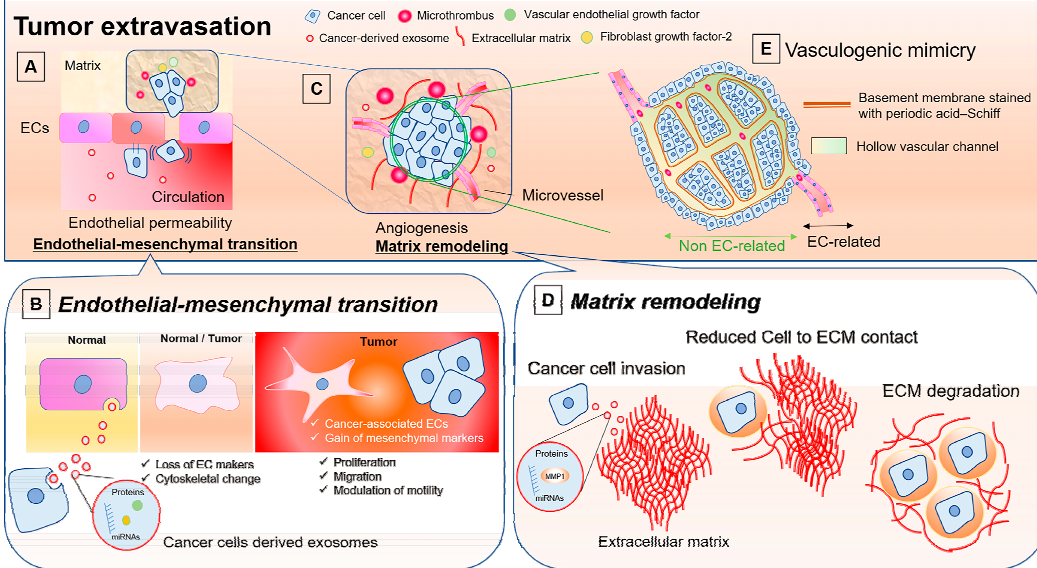
Figure 2. Effects of cancer-derived EVs on ECs in tumor extravasation. Attachment of circulating cancer cells to ECs and cancer-derived exosomes modulates tight junctions by activating ECs ( A ). Exosomes include proangiogenic miRNAs and growth factors and are involved in changing the phenotype of ECs. Activated ECs lose their markers and undergo a change in cytoskeleton. They gain mesenchymal markers and become cancer-associated ECs, which are proliferative and migratory. Endothelial-mesenchymal transition increases endothelial permeability and cancer cell invasion ( B ). The cancer cells induce inflammation by forming microthrombi and releasing growth factors, resulting in cancer cell growth and tumor angiogenesis ( C ). Cancer-derived exosomes are active in matrix remodeling via reduction of cell-to-ECM contact and degradation of the ECM through exosomal proteins, such as MMP-1 ( D ). When the cancer growth scaffold is established, the tumor microenvironment develops with a cancer-original vasculature that is not involved with ECs, known as vasculogenic mimicry ( E ). The vasculature may be regulated by cancer-derived exosomes, which are strongly associated with cancer progression. EC, endothelial cell; EV, extracellular vesicle; ECM, extracellular matrix.